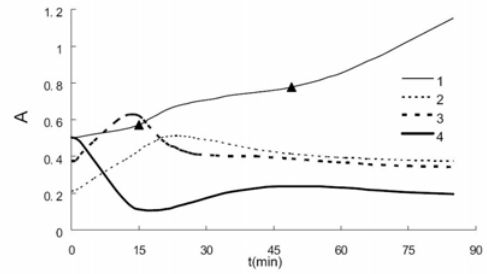
Fig. 10 A-t curves of the LiP catalyzed oxidation of VA in the presence of PR (40 μ M). Conditions: The reaction conditions were the same as in Fig. 9. [LiP] = 0.2 μ M;